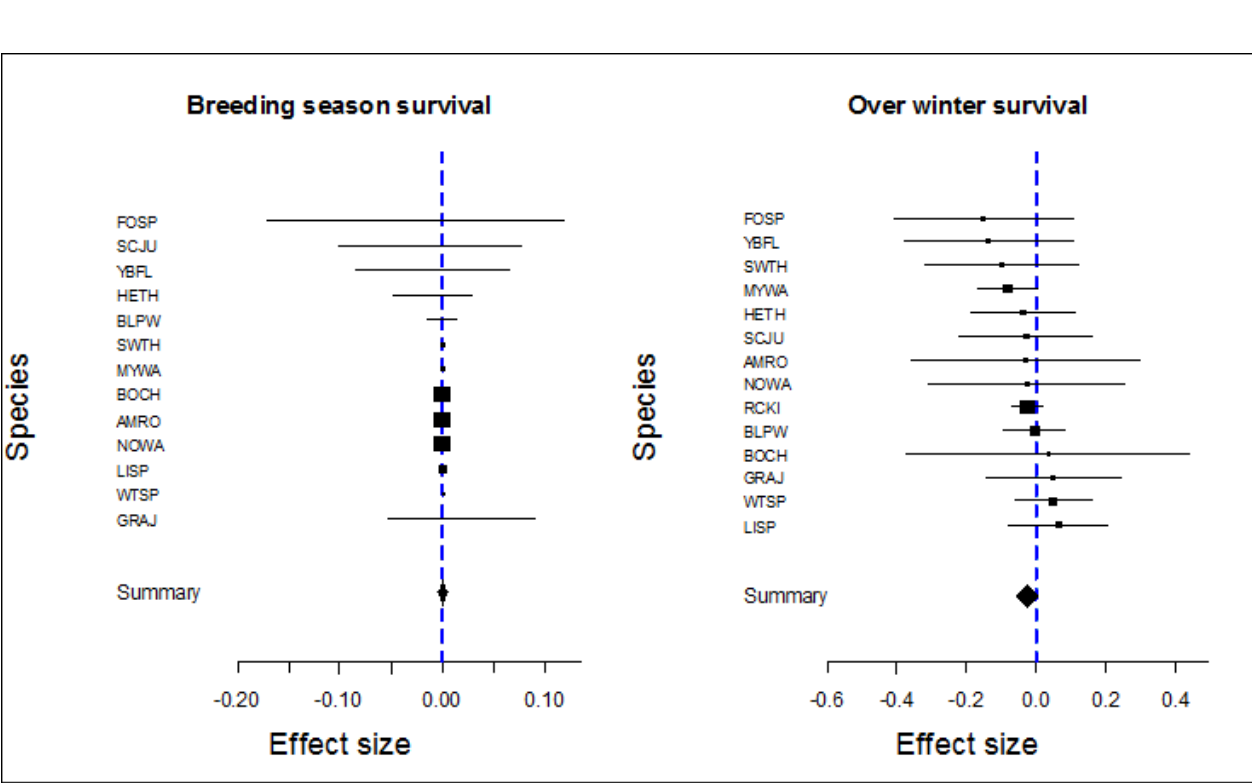
Fig. 2. Meta analyses of landscape differences in breeding season and over-winter apparent survival (S) ± 95% CI of boreal songbirds in western Newfoundland, 2003-2006. Observations for each species represent the difference in apparent survival between naturally fragmented landscapes and landscape modified by clearcutting (SNAT-SCUT), and are ordered based on the magnitude of the difference. Negative values indicate lower apparent survival in CUT landscapes. Squares vary in size to reflect the precision of each estimate, which was calculated as 1/SE² and used to weight each species during meta analyses. Note that in cases in which weights were very low, the square was so small as to be obscured by the horizontal line, which represents the 95% confidence interval on the difference. The black diamond at the bottom of each plot, labeled summary, is centered on the overall mean difference, and its width indicates the 95% confidence interval on the mean difference (breeding season mean = 0.000, 95% CI = -0.001-0.001; over-winter mean = -0.023, 95% CI = -0.054-0.009). Ruby-crowned Kinglet was dropped from the within-year plot because the species’ large confidence interval (-0.49-0.33) overwhelmed estimates for other species. Species codes are from Table